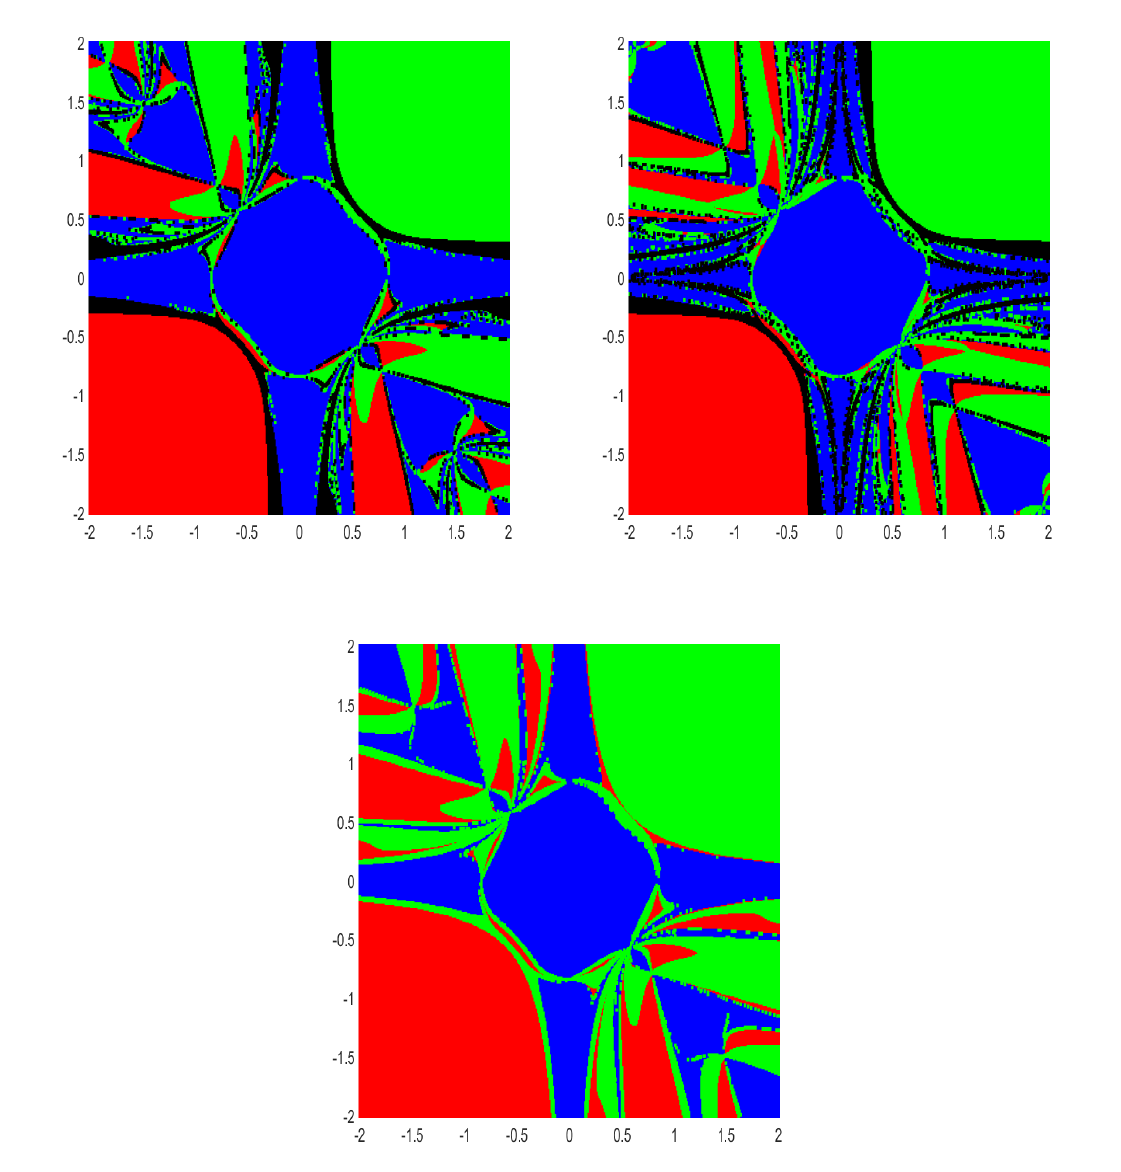
Figure 1. Dynamics of (2), (3) and (4), respectively, with BA, for Example